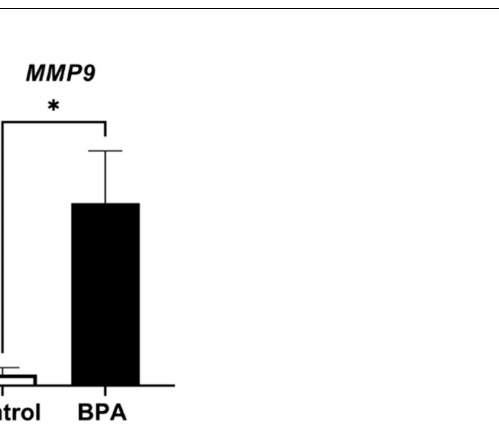
Figure 6. MMP9 mRNA expression in the control and BPA-treated groups. Note: * p < 0.05.